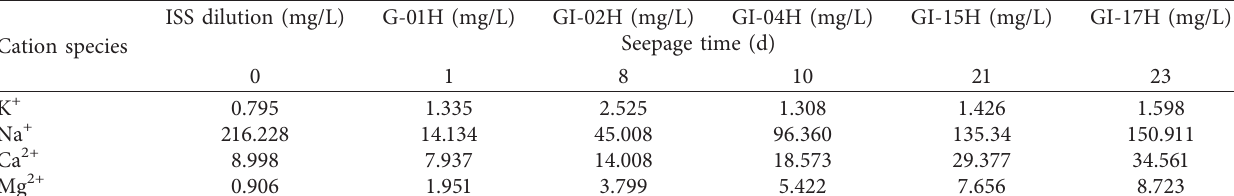
Table 9: Concentration of main cations from the exudate in different